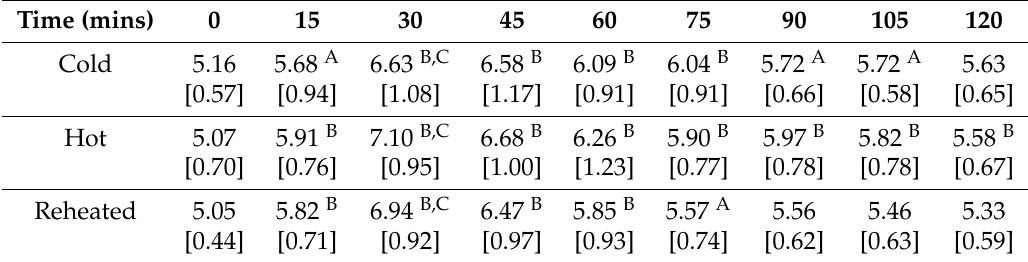
Table 1. Post-prandial glucose